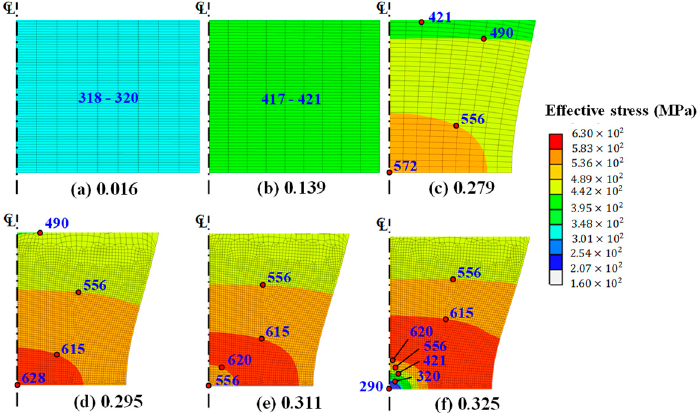
Figure 10. Change of effective stress (MPa) with engineering strain in the necking region with an emphasis on damage effect.